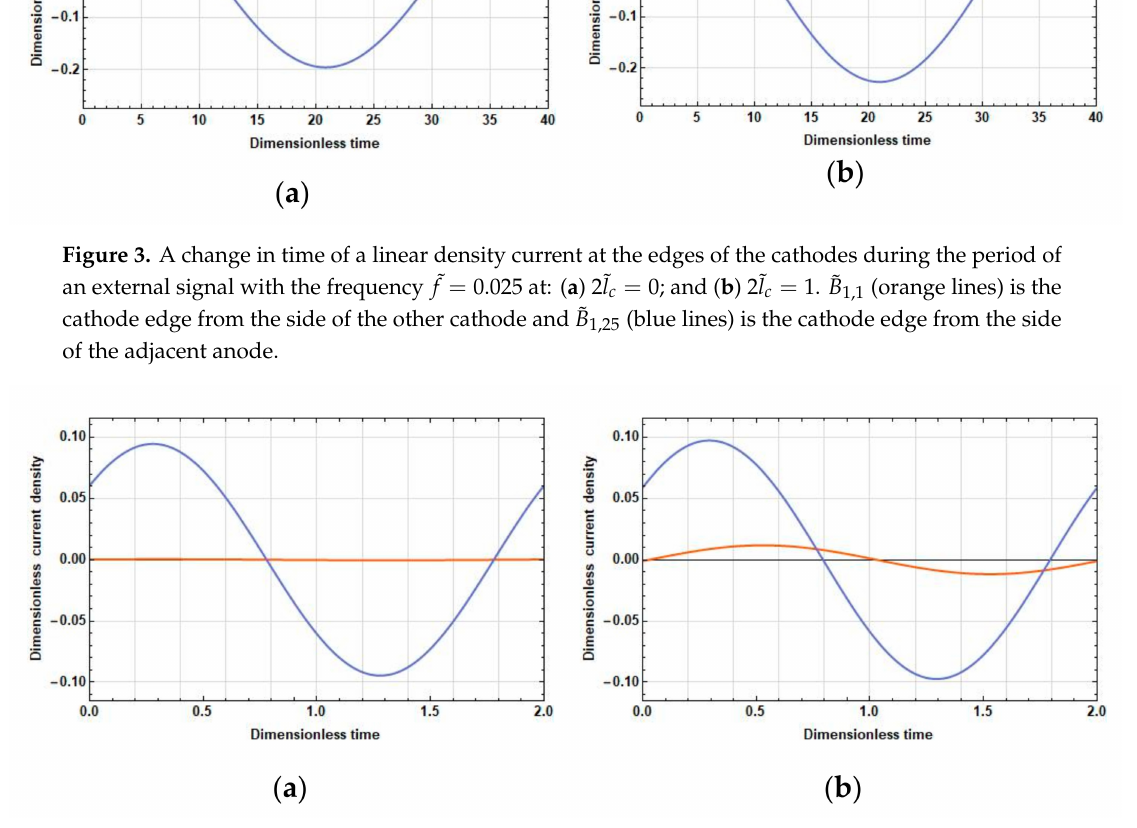
Figure 4. A change in time of a linear density current at the edges of the cathodes during the period of an external signal with the frequency ˜ f = 0.5 at: ( a ) 2˜ l c = 0; and ( b ) 2˜ l c = 1. ˜ B 1,1 (orange lines) is the cathode edge from the side of the other cathode and ˜ B 1,25 (blue lines) is the cathode edge from the side of the adjacent